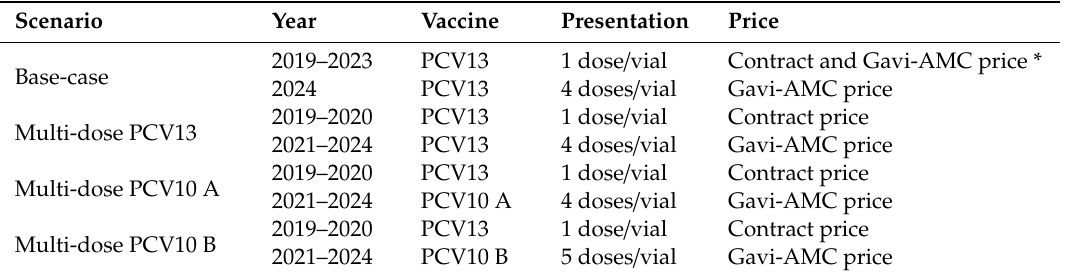
Table 4. Alternative scenario of switch options on the introduction of PCV.